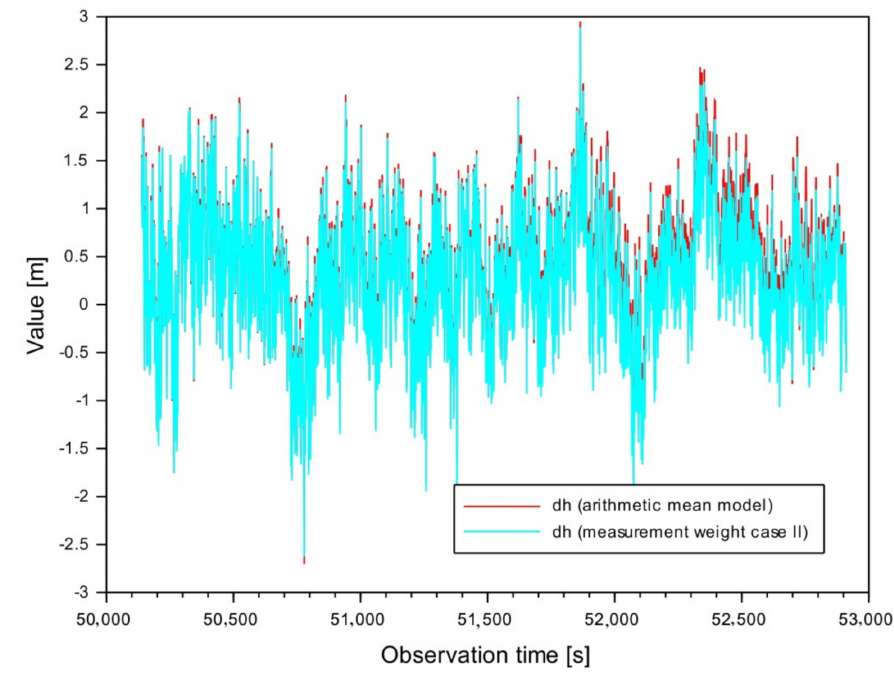
Figure 16. Results of position errors dh from the weighted mean model (case II) and arithmetic mean model.